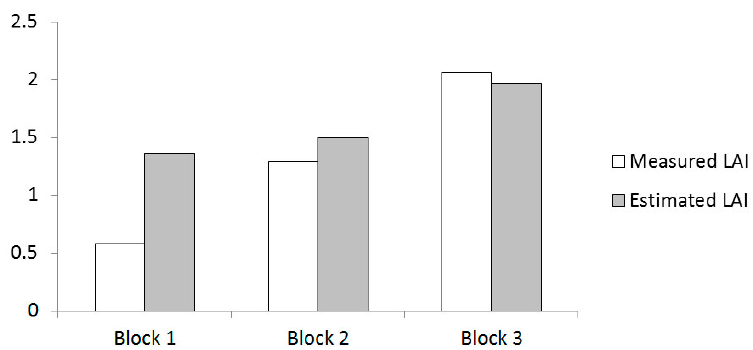
Figure 6. Measured and estimated LAI in three different contrasting vineyard blocks.